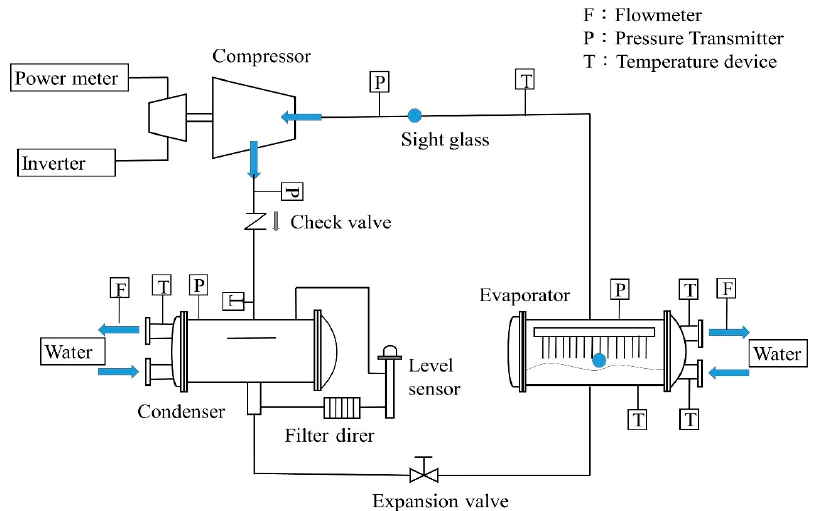
Figure 1. Schematic of the test facilty.